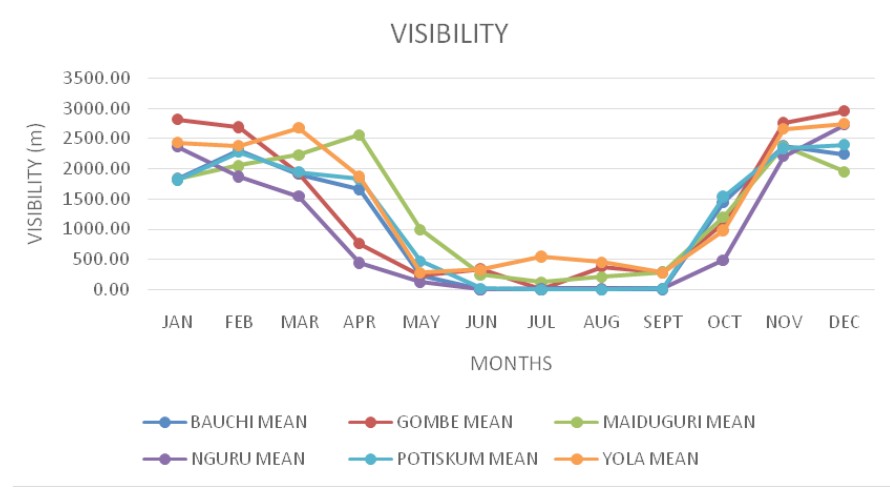
Figure 2: Long-term means monthly distribution of visibility (1984-2014). Table 2: Descriptive Statistics of Seasonal Air Visibility and Coefficient of